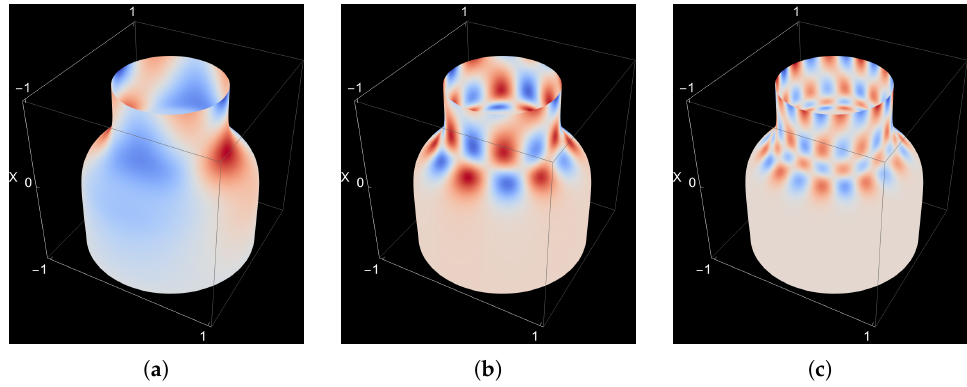
Figure 9. Case PEHP: transverse deflection w profiles. ( a ) t = 10 − 2 . Range w ∈ [ − 0.682738,0.584773 ] . ( b ) t = 10 − 4 . Range w ∈ [ − 159.457,125.7 ] . ( c ) t = 10 − 6 . Range w ∈ [ − 7109.61,6205.97 ]